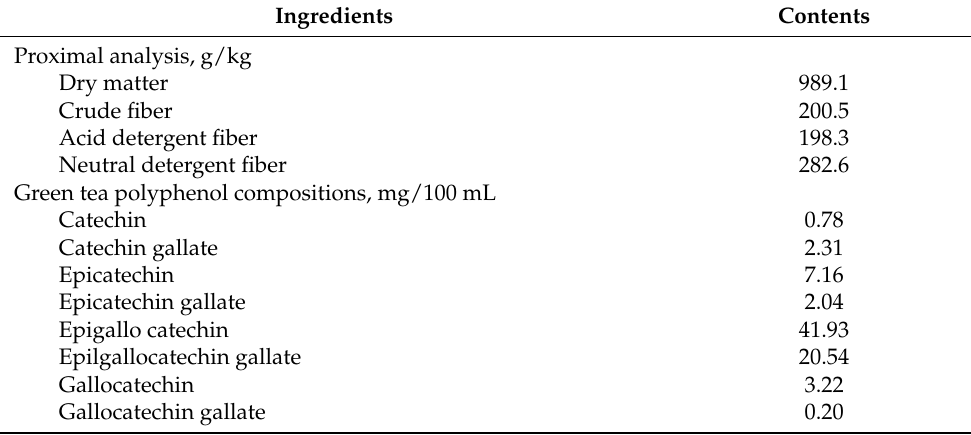
Table 1. Chemical compositions (on dry matter basis) and catechin contents of green tea